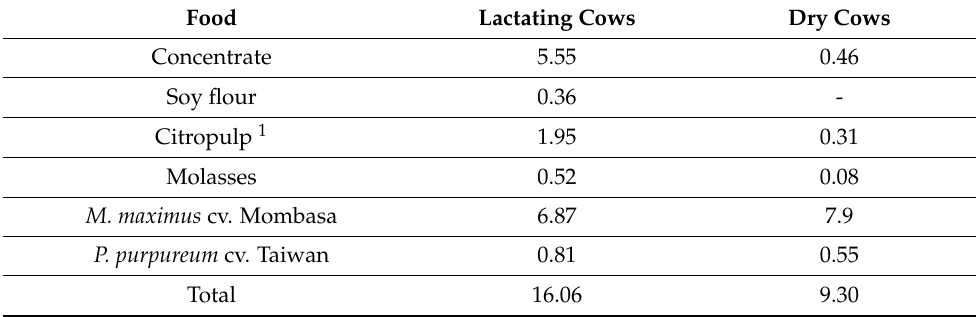
Table 2. Daily feed intake (kg DM cow − 1 ) by lactating and dry (non-lactating)